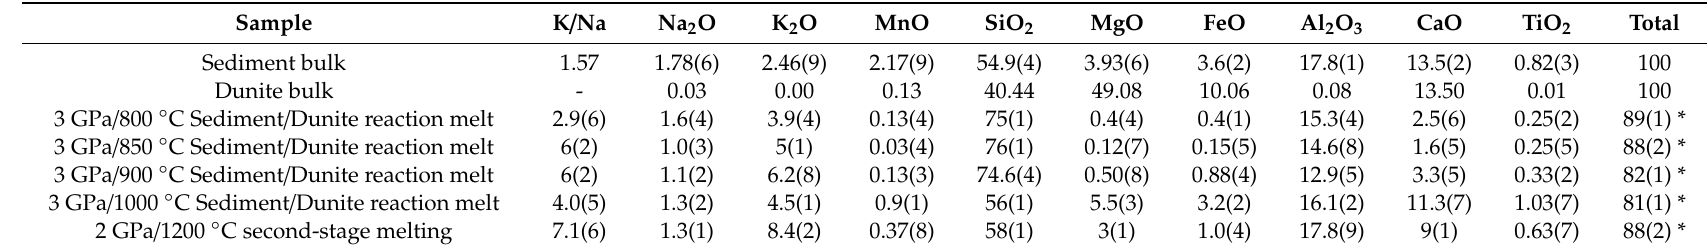
Table 2. Starting material and melt